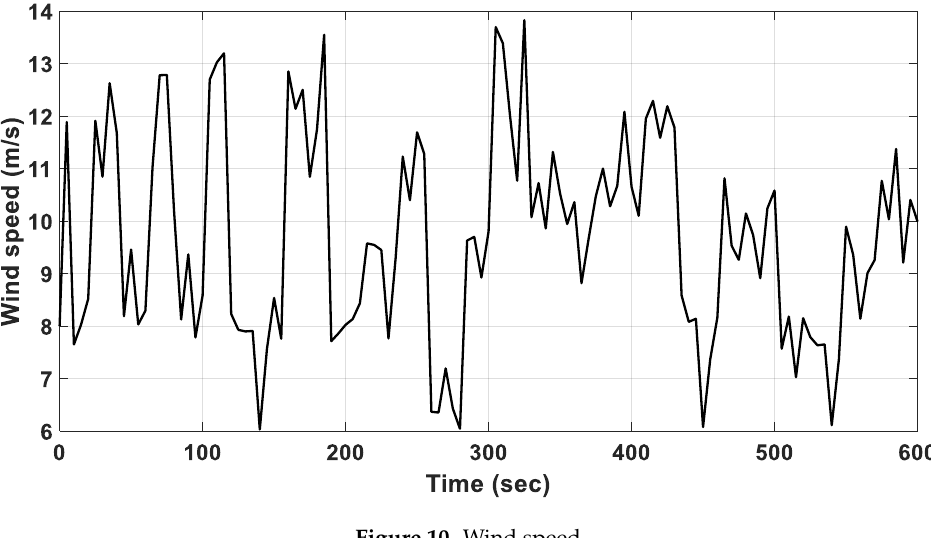
Figure 10. Wind speed.